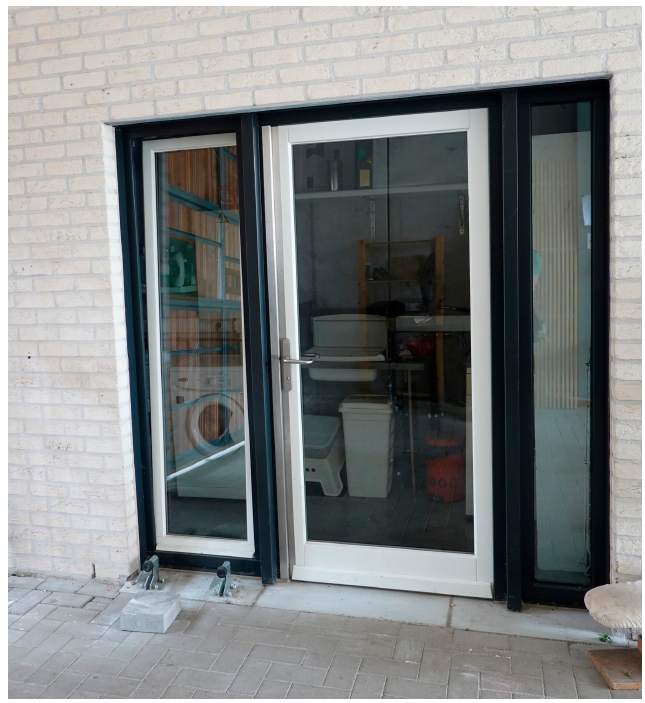
Figure 11. The communal laundry room in l’Echappée (photo by the authors, 2019).